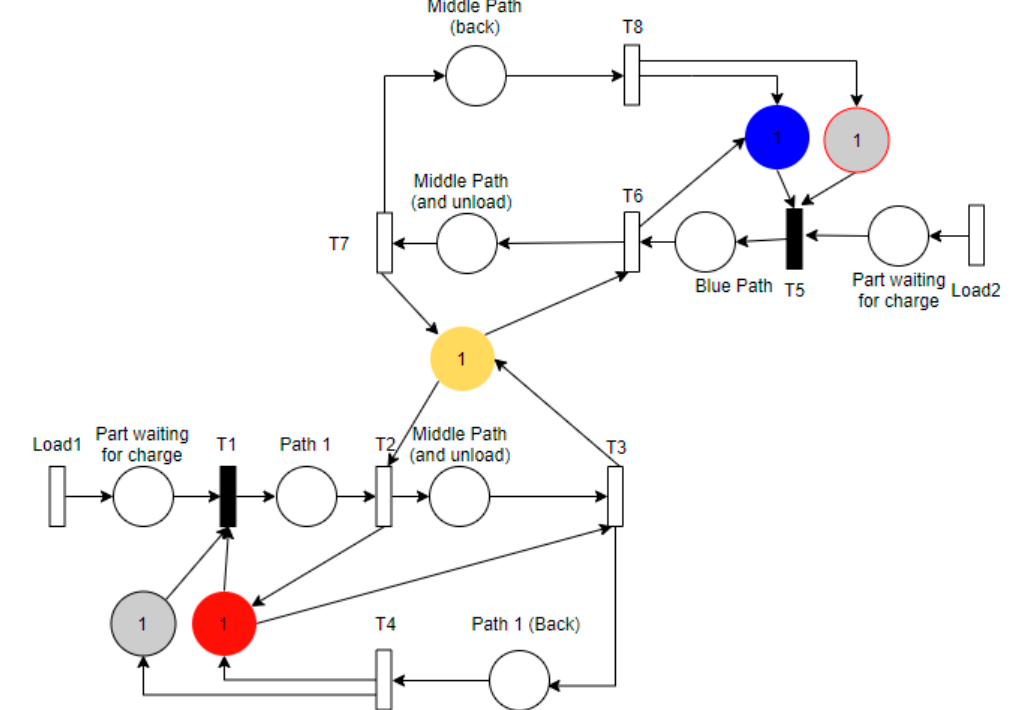
Figure 19. Case IV: proposed deadlock solution (blocking the middle path).